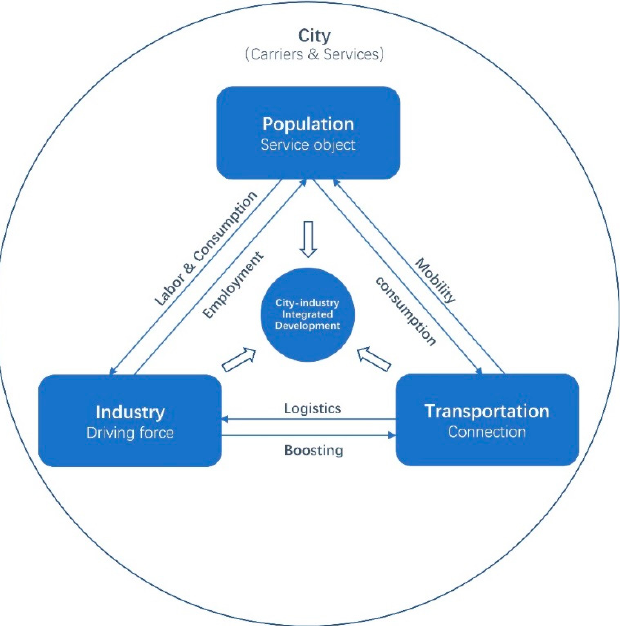
Figure 1. The theoretical framework of city–industry integration development. A city is a huge, open, and complex system mainly composed of a population